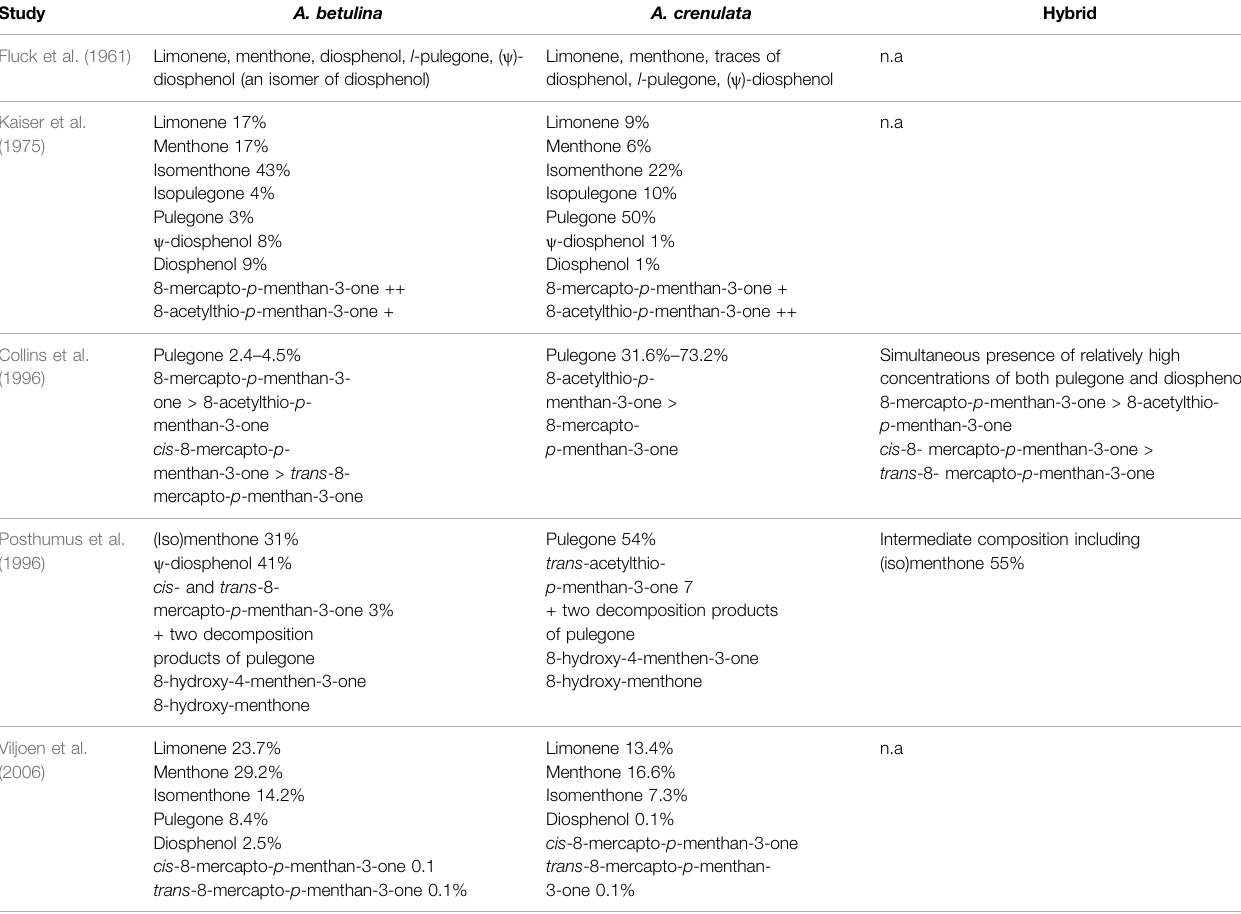
TABLE 3 | Comparable overview of the phytochemical composition of the essential oil determined for A. betulina and A. crenulata and the hybrid of both.